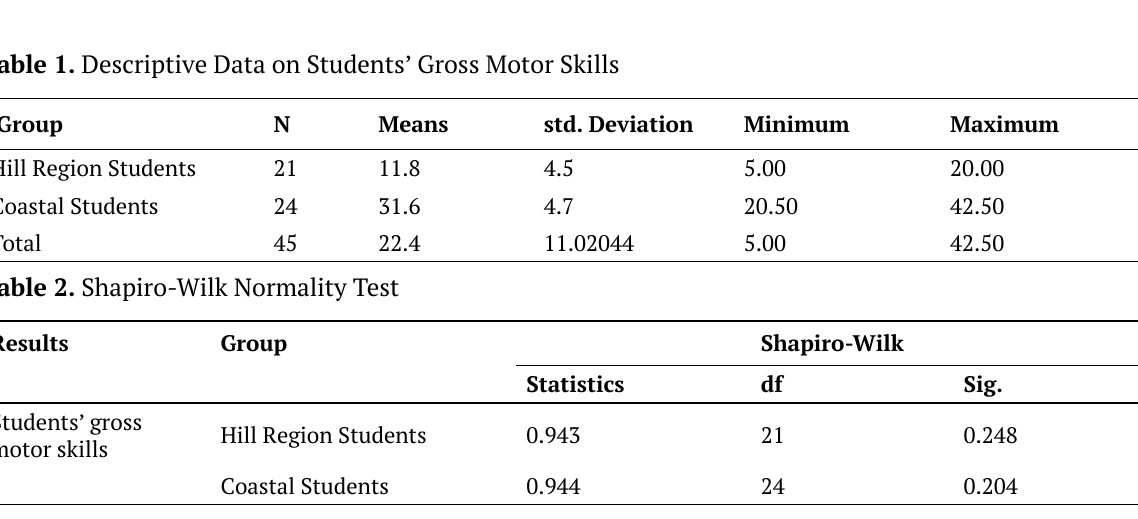
Table 3. Test of Homogeneity of Variances